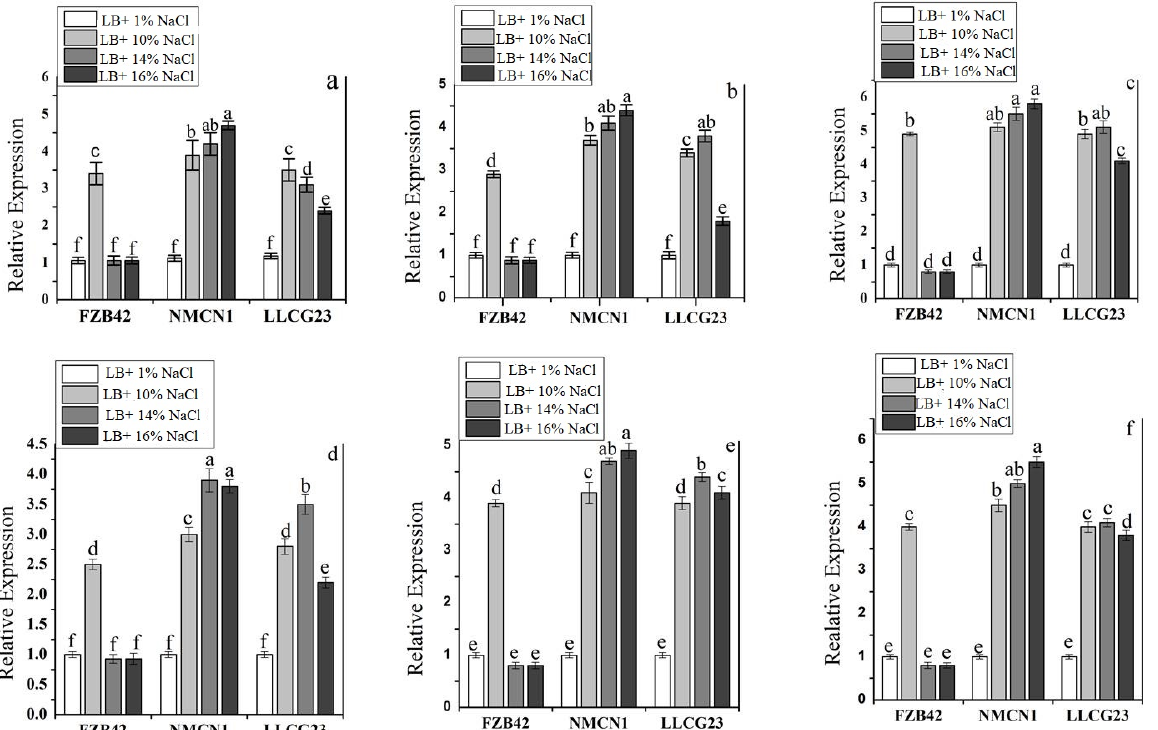
Figure 2. Expression analysis of predicted genes in Bacillus strains FZB42, NMCN1 and LLCG23 grown in different NaCl concentrations (1%, 10%, 14% and 16%). The genes analysed were: DegU ( a ), OstB ( b ), OhrR ( c ), ComA ( d ), SodA ( e ) and OpuAC ( f ). The error bars on the columns indicate the standard deviation of the mean ( n = 3). Letters above the columns represent significant differences between treatments at p ≤ 0.05. The expression studies were repeated thrice with three replicates for each